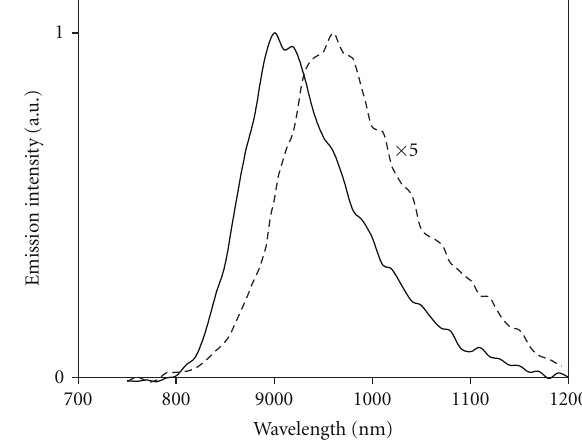
Figure 3: Emission spectra of complex A3 in ethanol-methanol (4: 1) solution at 77 K (——) and 298K (–